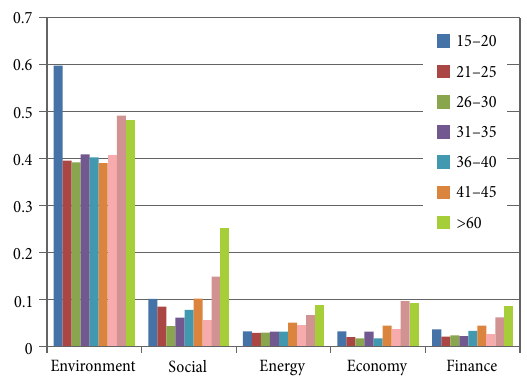
Fig. 4. Composite Index of level of sustainability from age perspective